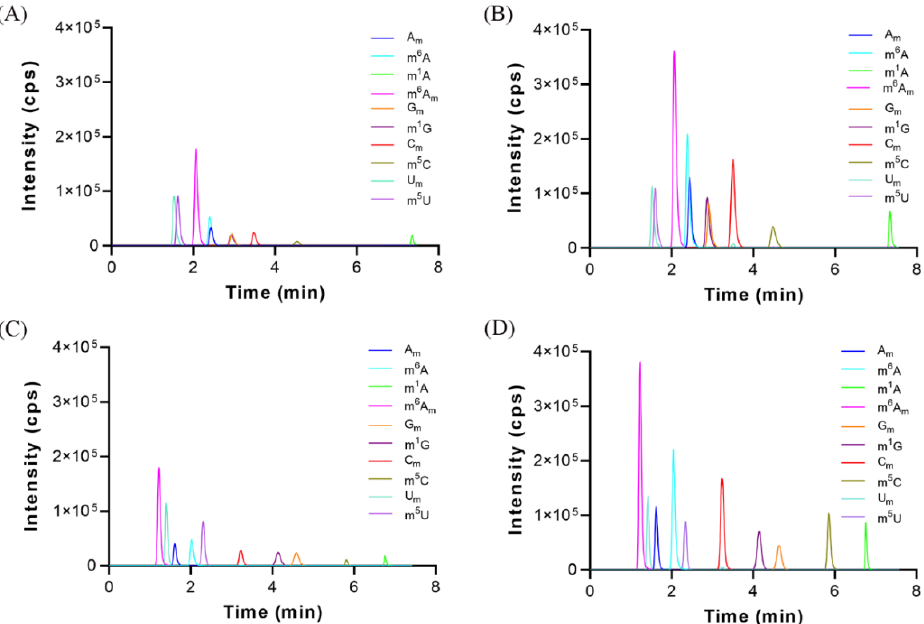
Figure 2. The multiple reaction monitoring (MRM) chromatograms under different conditions. ( A ) BEH HILIC column, without the use of malic acid, ( B ) BEH HILIC column, with the use of malic acid, ( C ) BEH Amide column, without the use of malic acid, and ( D ) BEH Amide column, with the use of malic acid. The concentrations of U m and m 5 U were 1000 nM, and the concentrations of other nucleosides standards were 20 nM. The injection volume was 5.0 μL.